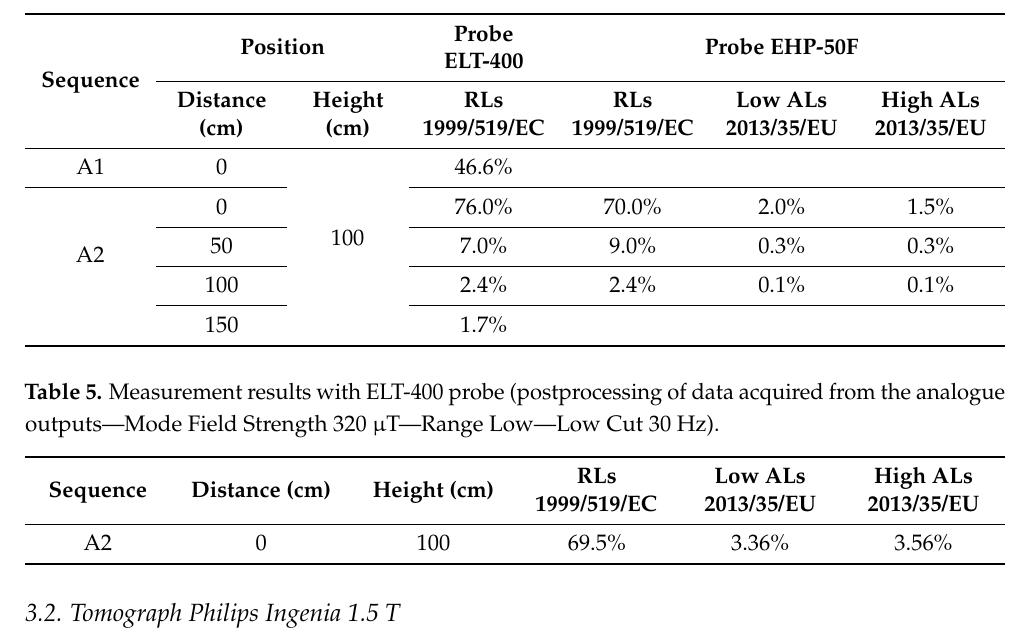
Table 4. Measurement results with the ELT-400 probe (Display values—Mode Exposure STD ICNIRP 1998 General Public—Range Low—Low Cut 30 Hz—Detector STND) and EHP-50F (Mode WP, magnetic field, full scale 100 µ T).